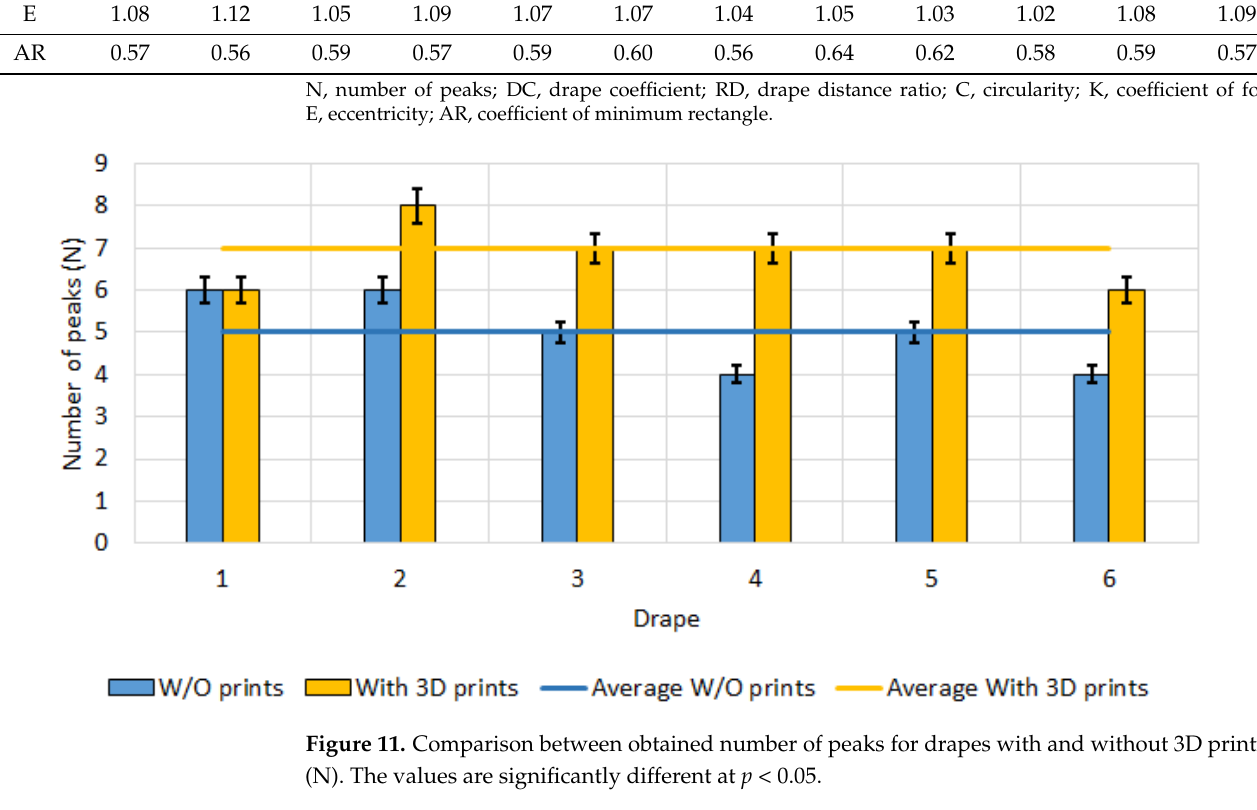
Figure 11. Comparison between obtained number of peaks for drapes with and without 3D printing (N). The values are significantly different at p < 0.05.